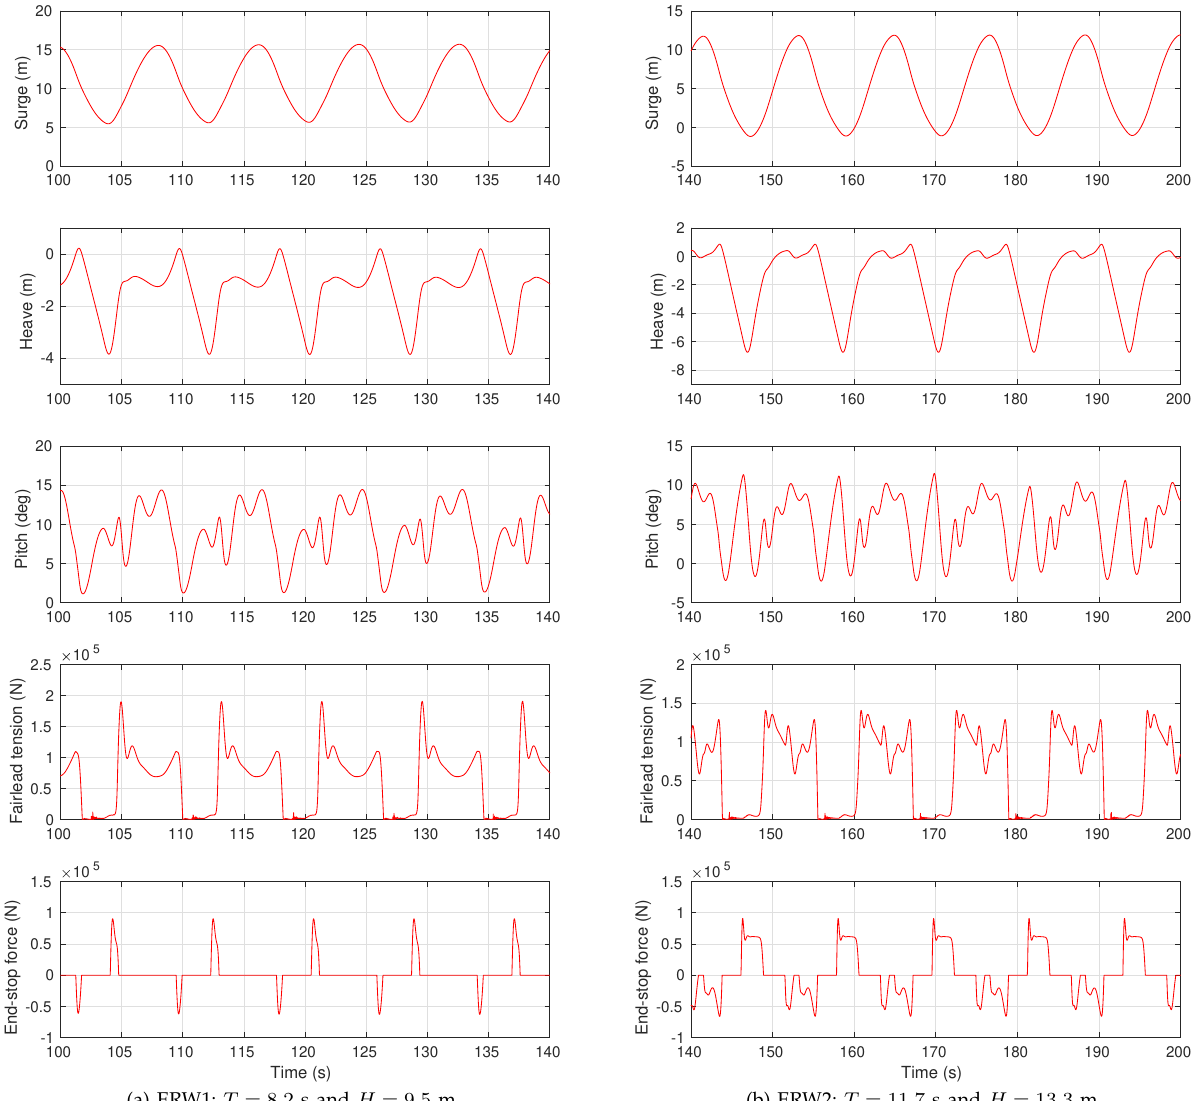
Fig. 4. Baseline simulations of the equivalent regular wave ERW1 (left) and ERW2 (right) cases.